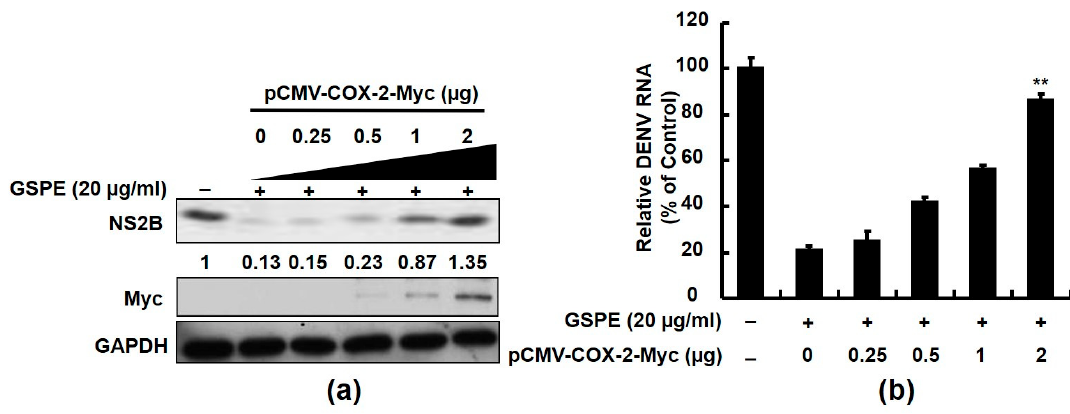
Figure 3. Exogenous overexpression of COX-2 attenuates the anti-DENV activity of GSPE. Huh-7 cells were transfected with the indicated amounts of pCMV-COX-2-Myc (0.25, 0.5, 1, and 2 µg) for 8 h. The transfected cells were infected with DENV-2 at an MOI of 0.1 for 2 h and then treated with 20 µg/mL of the GSPE for 3 days. ( a ) Western blo tt ing was performed with anti-NS2B, anti-Myc, and anti-GAPDH (loading control) antibodies to analyze protein expression. The relative DENV NS2B protein levels were presented as fold-change values compared to the GSPE-untreated Huh-7 cells. ( b ) The DENV RNA levels were quanti fi ed by RT-qPCR following normalization of cellular gapdh mRNA. Relative DENV RNA levels were presented as percent changes compared to GSPE-untreated/non-transfected Huh-7 cells, which were considered 100%.”0” indicates the transfection of vehicle plasmid. Data are presented as mean ± SD of three independent experiments. ** p < 0.01.